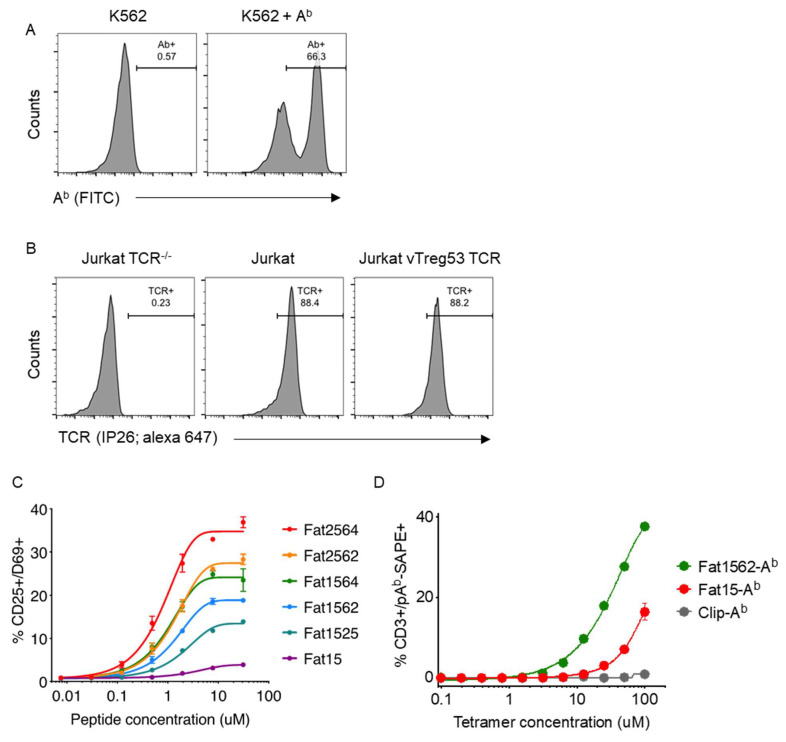
In vitro peptide stimulation of the vTreg53 TCR cells.(A) Expression of wild-type Ab MHC in stably transduced K562 cells. (B) Expression of vTreg53 TCR in stably transduced Jurkat T cells (TCRαβ-/-). (C) Fraction of CD25+/CD69+ cells following overnight stimulation with Fat mimotopes at the indicated concentrations. (D) Peptide-Ab - streptavidin PE (pAb -SAPE) titration of vTreg53 transduced Jurkat T cells. Cells were stained with 250 nM of pAb-SAPE tetramer for 1 hr. (C, D) Data are mean ± SD from n = 2 biological replicates from 1 representative of 3 independent experiments.